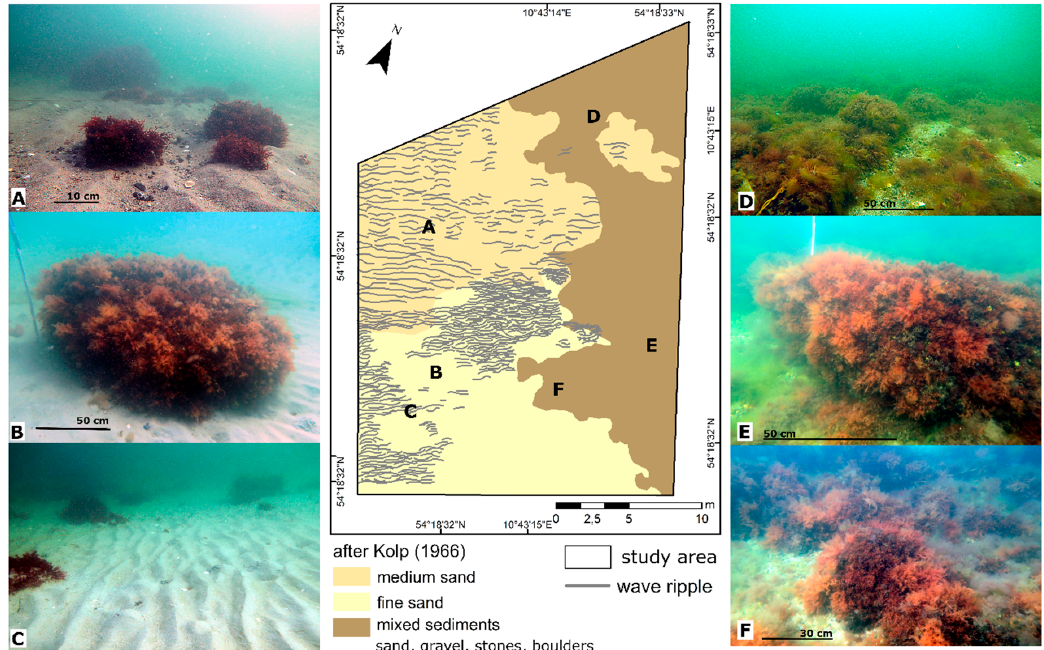
Figure 3. Sediment types in the study area classified after Kolp (1966) [8]; ( A – F) Stones and boulders.